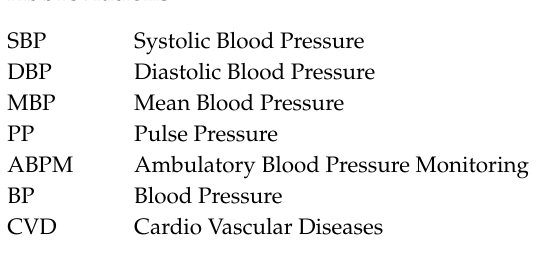
Figure S3: Forest plot of the linear regression analyses exploring the association between the daytime / nighttime urinary sodium excretion ratio and MBP and PP (daytime, nighttime and nocturnal changes) by age